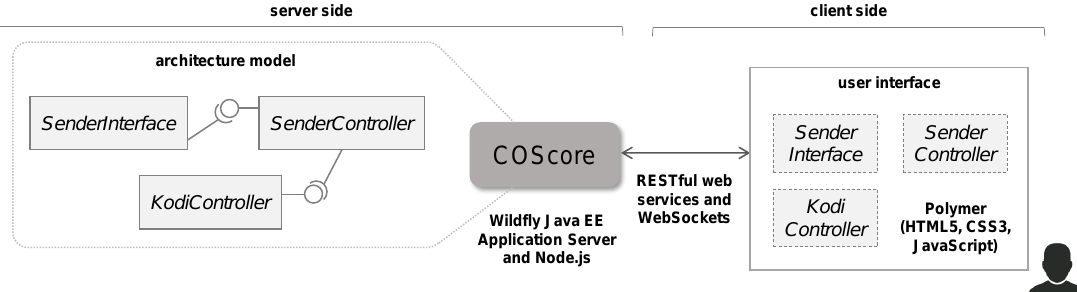
Figure 2. Main parts of the background technology